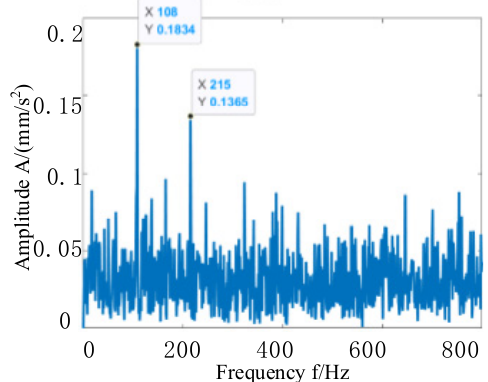
Figure 16. Envelope spectrogram of the noised signal.